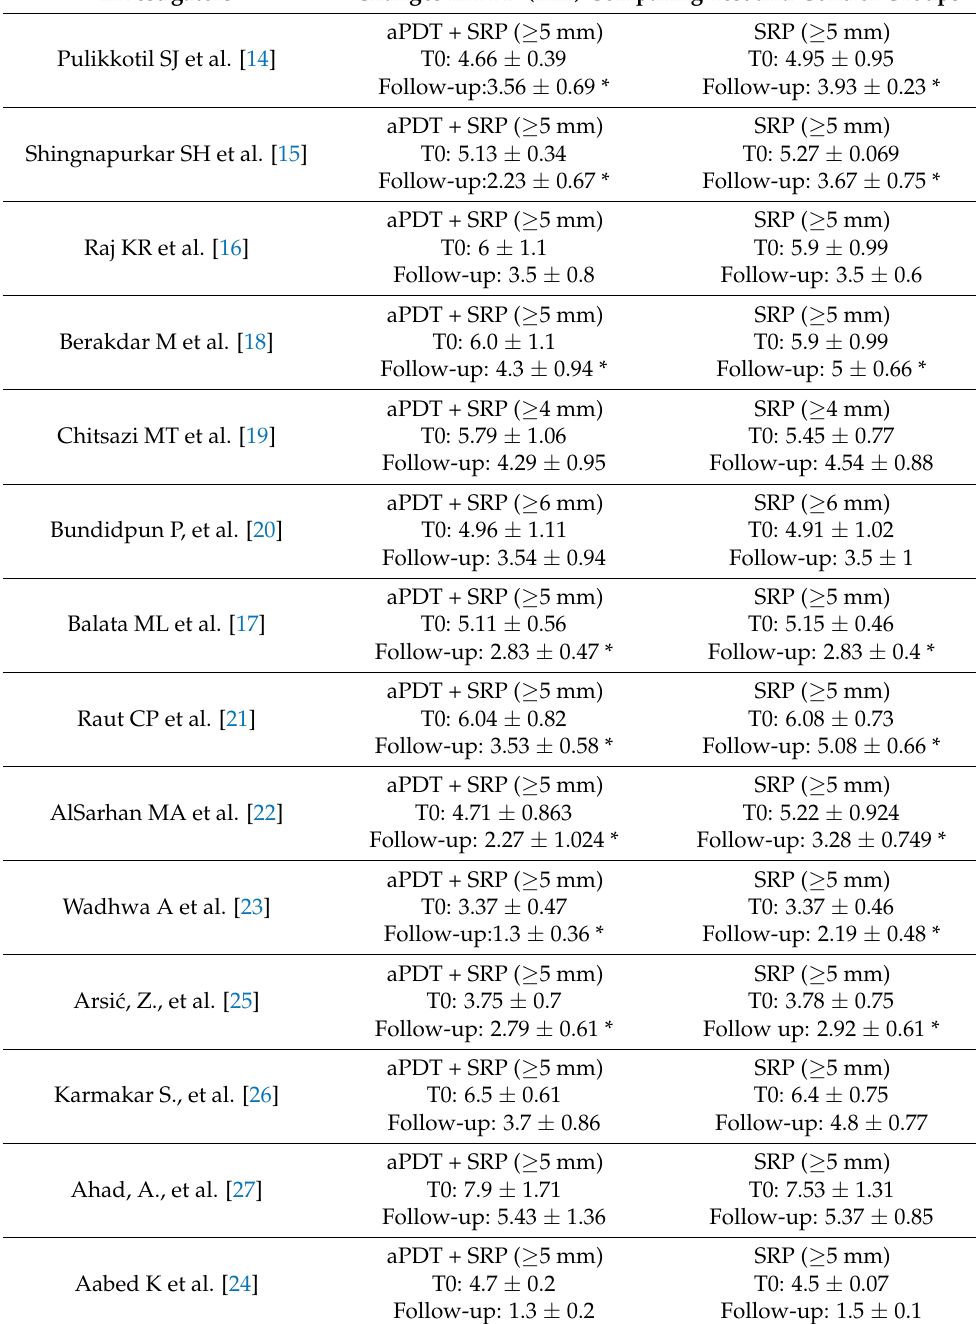
Table 2. Outcomes (PPD) of the research articles included in the current review.